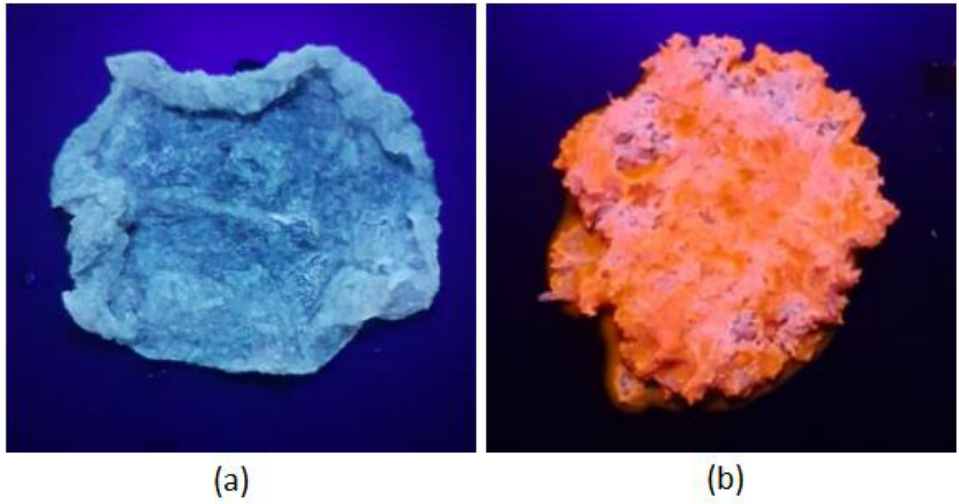
Figure 6. Chitosan sponges saturated with CQDs solutions visualized under UV light ( a ) Dot-1 sample; ( b ) Dot-1-R sample .